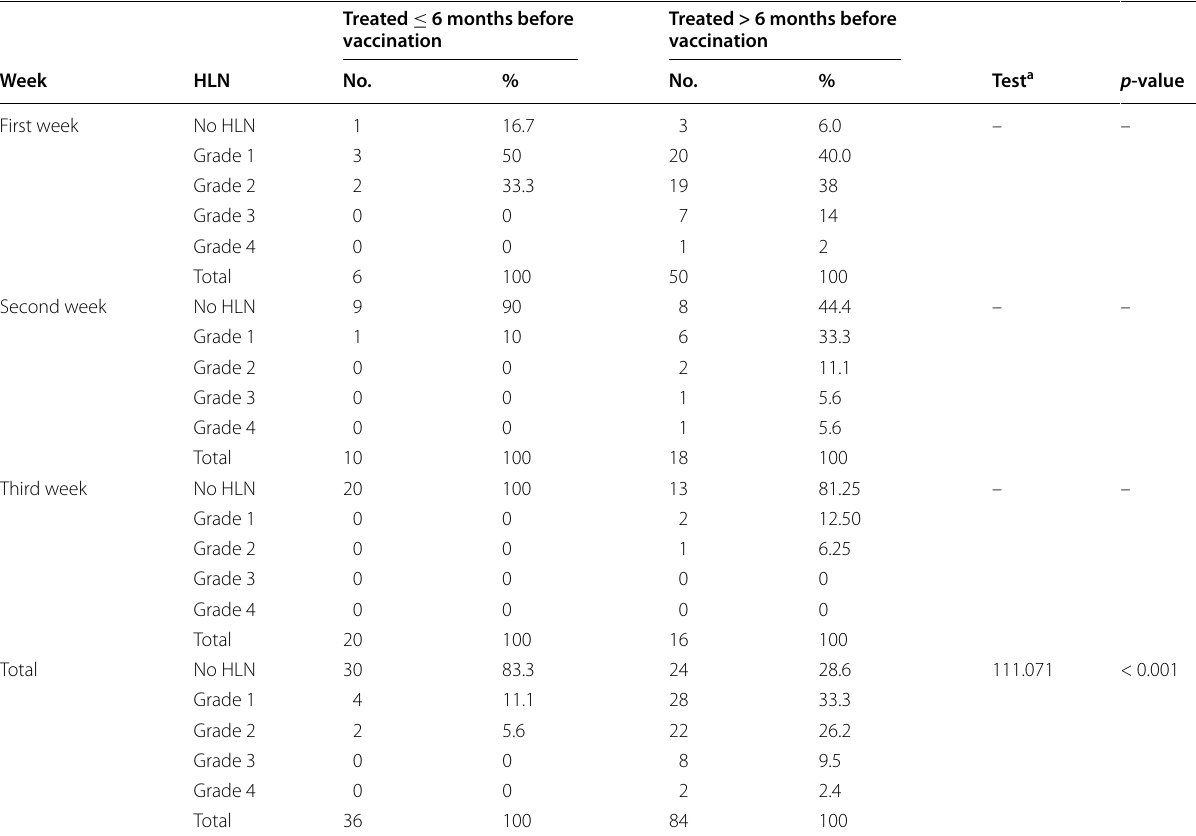
Table 2 Comparison between patients treated regarding HLN stratified by examination time